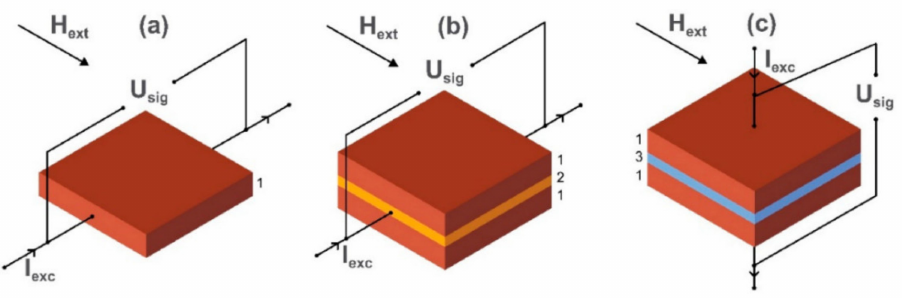
Figure 13. ( a ) Schematic of ( a ) anisotropic magnetoresistance, ( b ) giant magnetoresistance, and ( c ) tun- nel-ing magnetoresistance magnetic field sensors are shown. Here, Iexc, Hext, and Usig are the current flowing through the structure, the external magnetic field, and the applied voltage, re-spectively. Reprinted with permission from D. Murzin, et al., 2020 MDPI under the terms and conditions of the Creative Commons Attribution (CC BY) license http://creativecommons.org/licenses/by/4.0/, accessed on 28 June 2021.